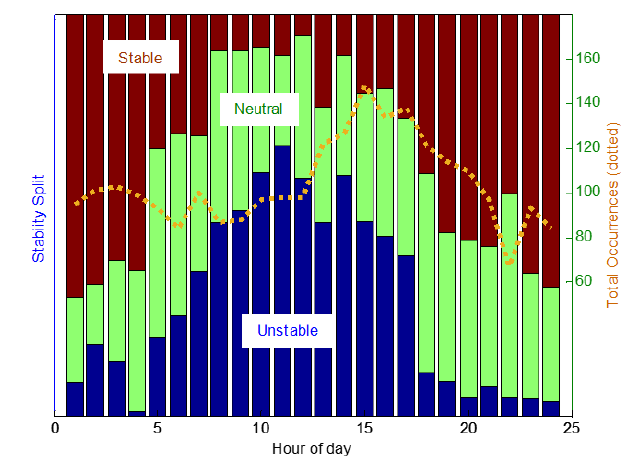
Figure 3. Diurnal distribution of atmospheric stability conditions, classified into three categories based on the bulk Richardson num- ber estimated from the site mast at the Sedini wind farm